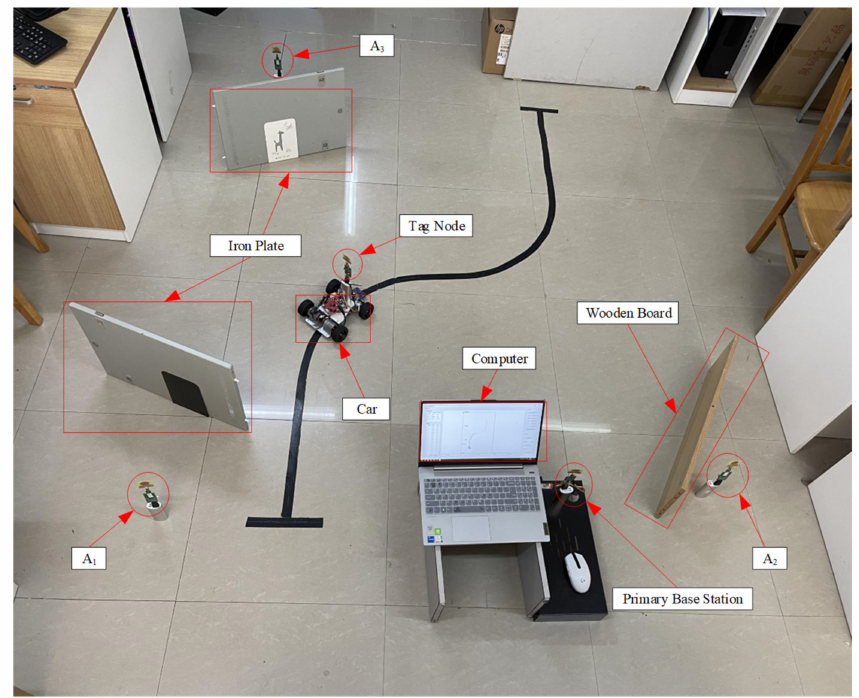
Figure 9. Environment of the dynamic positioning experiment.